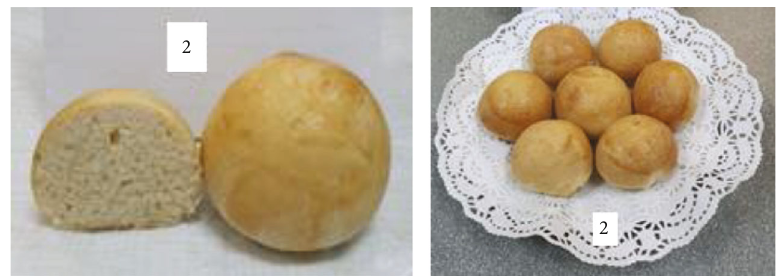
Figure 3: Sample no. 2 with 30g of sugar beet powder added.